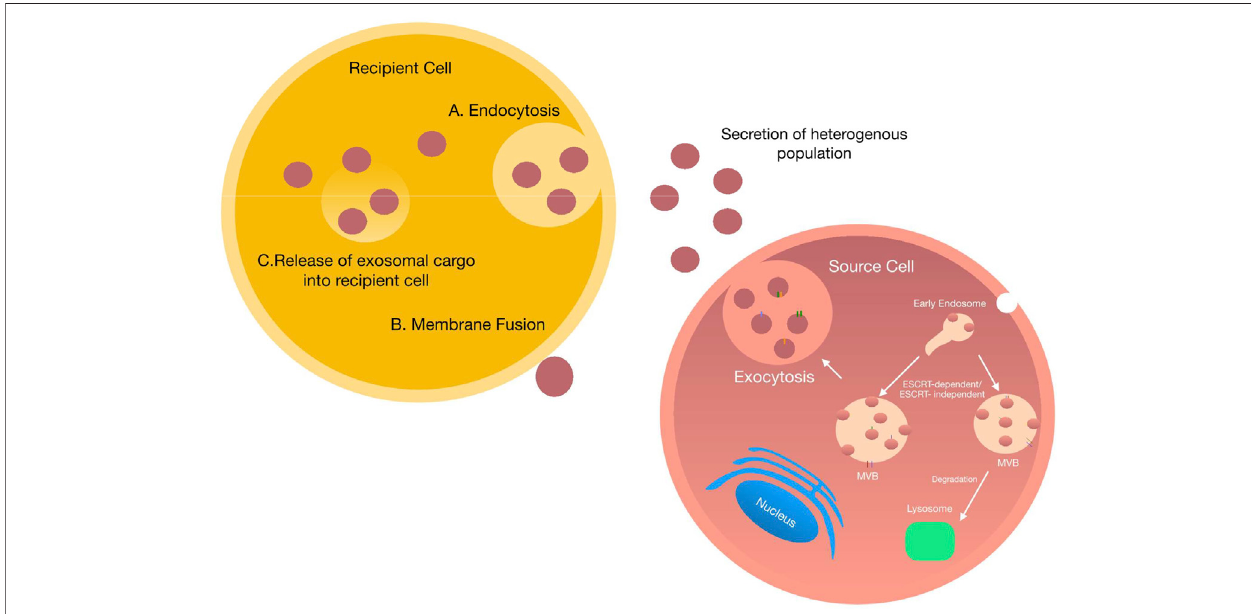
FIGURE 3 | Exosome uptake by neighbouring cells: Schematic representation of exosome uptake by neighbouring cells. Once secreted into the extracellular space, exosomes can be taken up by neighbouring cells via two main processes i) exosomes are engulphed into the target cell via endocytosis. Once endocytosed exosomes fuse with the endocytic compartment delivering various cargo ii) exosomes dock onto the plasma membrane of the target cell and directly deliver their cargo into the cytoplasm of the target cell.